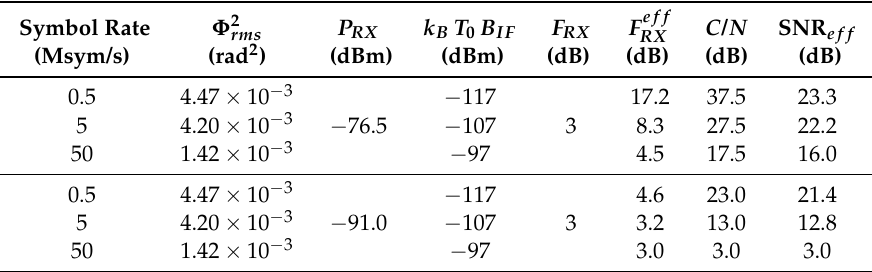
, C / N and SNR ef f versus the Symbol Rx